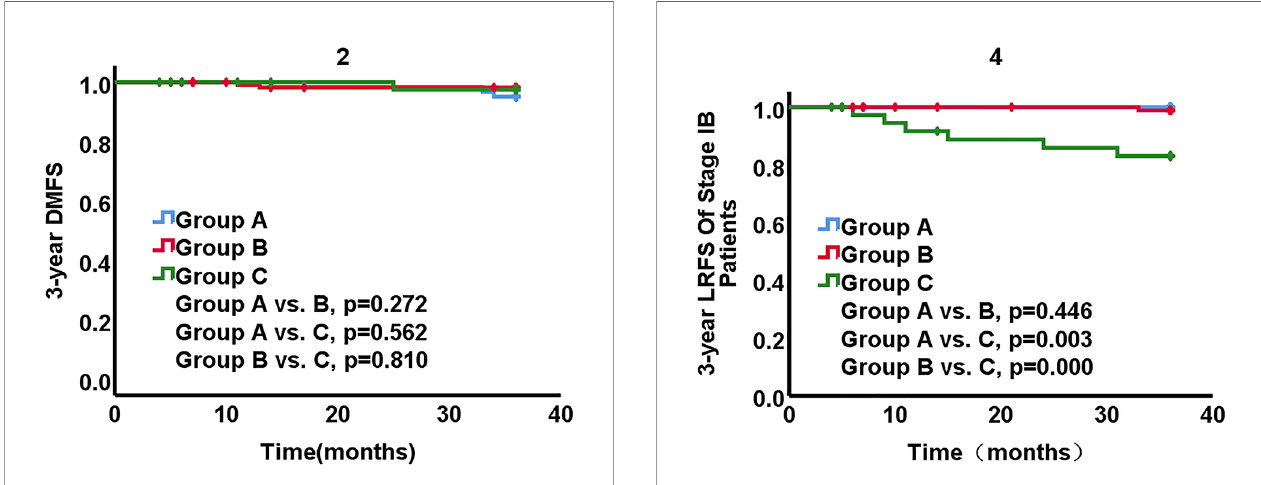
FIGURE 4 | Local recurrence-free survival (LRFS) strati fi ed by three groups for patients with stage IB1-IB3 disease.